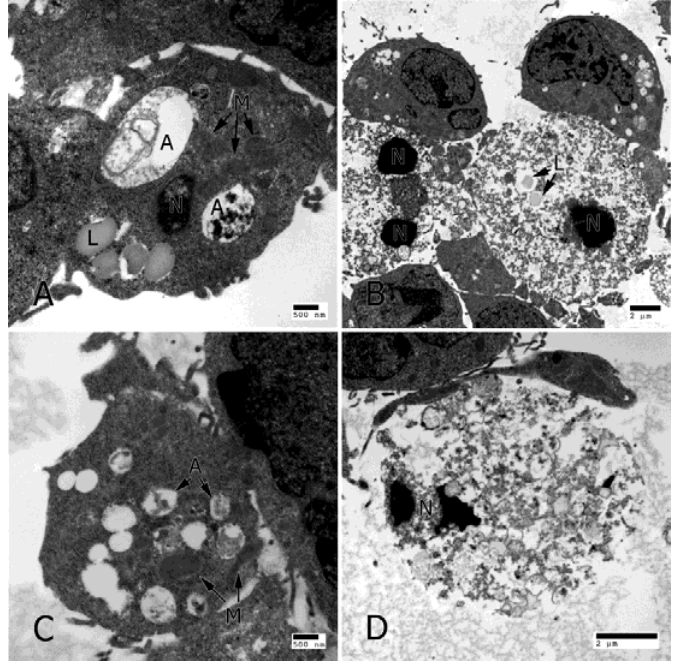
Figure 1. Electron micrographs showing pyroptosis in mouse retinal stem cells (RSC) in response to in vitro application of IL-1 β and IL-18 (A). IL-1 β induced mitochondrial (M) damage, autophagy ( A ), glycogen accumulation (not labeled), lipid droplets (L), and nuclear condensation (N); ( B ) IL-1 β induced advanced disintegration of cytoplasm in RSCs; ( C ) IL-18 induced mitochondrial (M) damage and autophagy (A); ( D ) IL-18